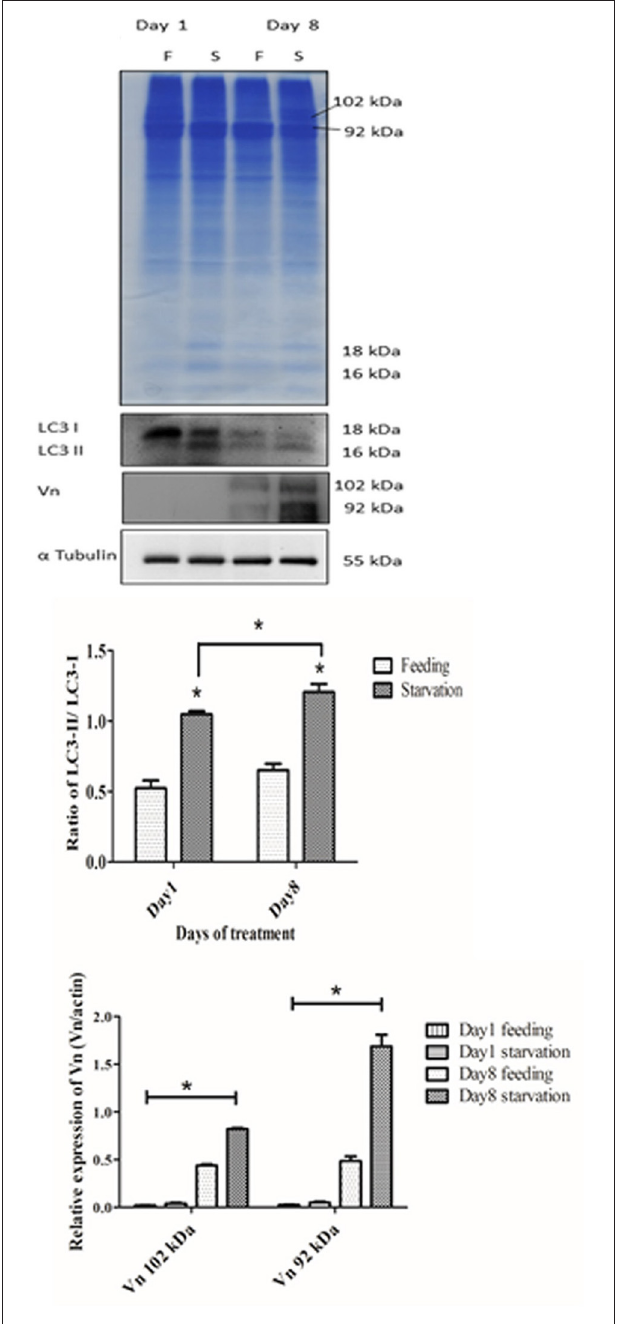
FIGURE 7 | Effect of starvation on the expressions of autophagic marker proteins and vitellin (Vn) in the ovaries. Immunoblot showing the relative levels of LC3 I and II, Vn and β -tubulin in ovaries of fed and starved prawns. Both LC3-II and Vn showed significantly increased amounts in starved prawns’ovaries in comparison to fed prawns’ovaries, especially at day 8 ( n = 5). Asterisks indicate significant differences with p < 0.05.